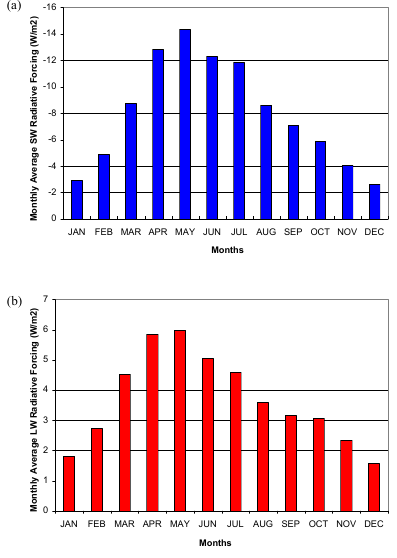
Fig. 12. Monthly average dust radiative forcing over the entire do- main in (a) the incoming shortwave radiation and (b) the incoming longwave radiation on the